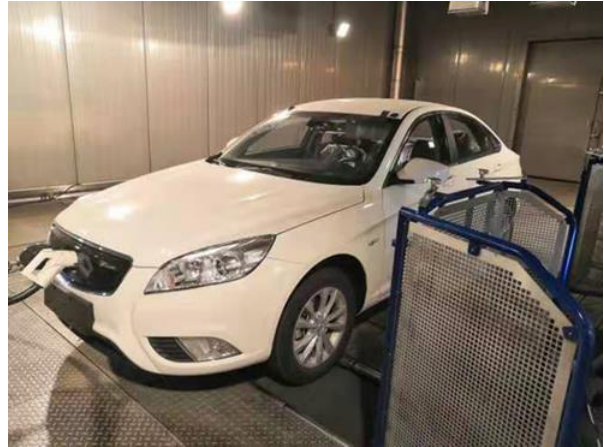
Figure 5. Drum test of a test car in the laboratory.